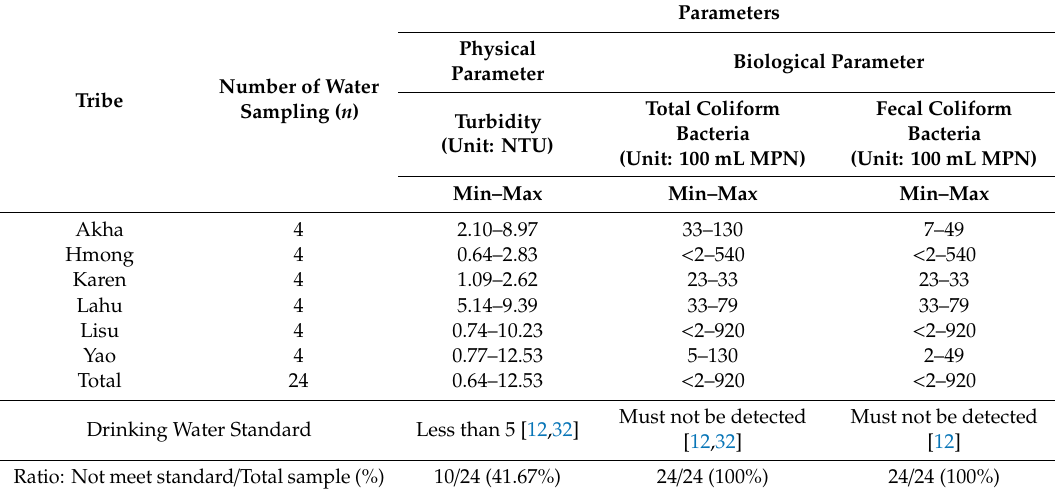
Table 5. Water quality of mountain water supply of six hill tribe